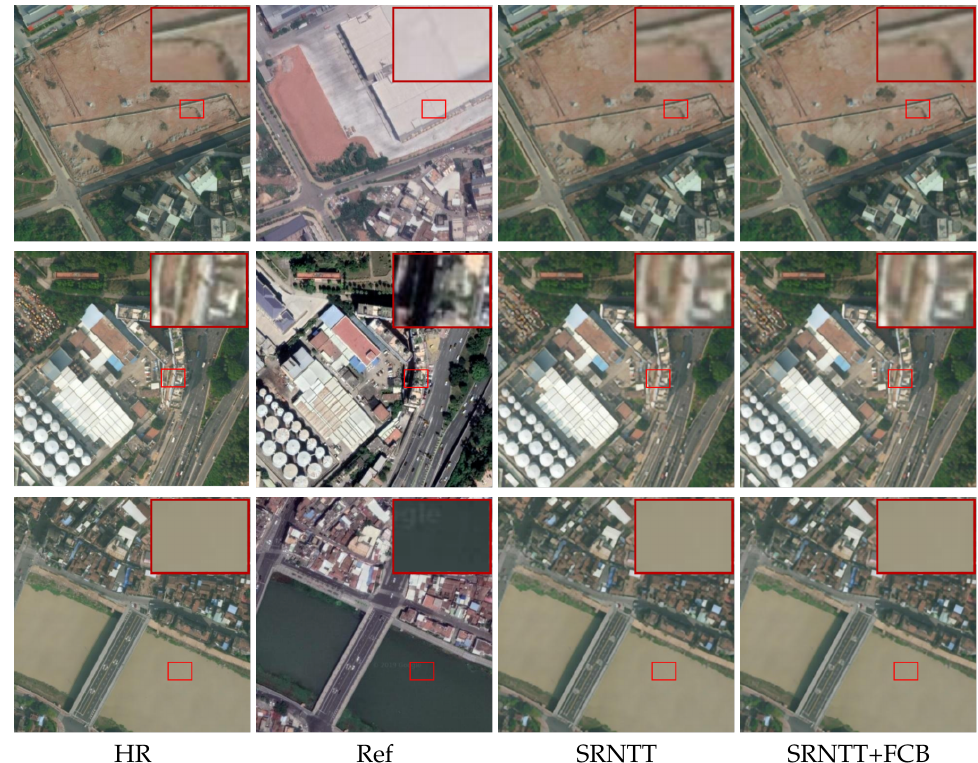
Figure 7. Visual comparison between SRNTT and SRNTT+FCB of ×4 factor on diverse test sets. We enlarge the image details inside the light red rectangle and show in the red rectangle in the upper right